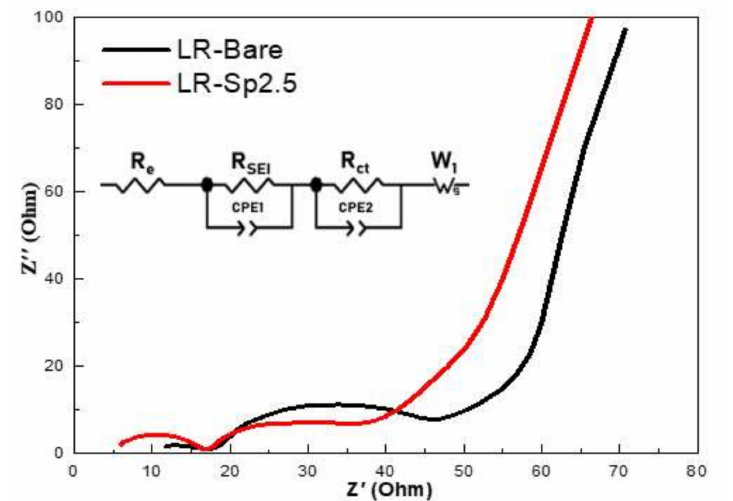
Figure 9. Electrochemical impedance spectra of LR–Bare and LR-Sp2.5 after 25 charge– discharge